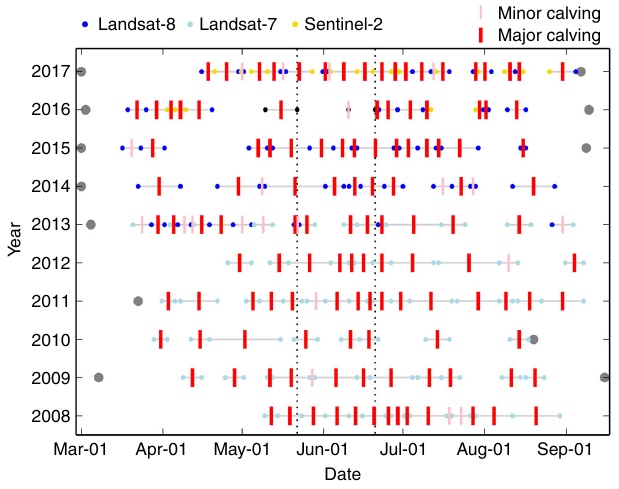
Fig. 4 Calving events inferred from TRI and satellite images. Due to limited temporal sampling of the data, we are not able to determine the exact time of each calving event. Instead, we mark each calving event in time de fi ned by the closest two usable images (colored dots), de fi ned as no dense cloud coverage at the glacier front in the satellite images. Black dots at 9 and 21 May 2016 represent the acquisition times of two Sentinel-1 images. Black dots at 10 and 20 June 2016 represent acquisition times of TRI images. Two vertical dotted lines mark the 30-day period between 21 May to 20 June. For each year, the time between the grey dot on the left ( fi rst acquisition of satellite image between the study period of the year) and the useable image represent the earliest period without calving. If the image represented by the fi rst blue or light blue dot shows no calving events compared to an image before 00:00 1 March in the corresponding year, we put the grey dot at 00:00 1 March. E.g., Landsat-8 images acquired at 14:54 26 February 2017 to until 14:54 15 April 2017 show no calving event during this period. If there is no grey dot on the left of the corresponding year (in 2008, 2010, 2012, due to cloud coverage on Landsat-7 optical images), then the fi rst light blue dot represents the fi rst usable image in the corresponding year. Similarly, grey dot on the right for each year indicates the last usable image that shows no calving event compare to the image shown by the last blue or light blue dot in the corresponding year. If there is no grey dot on the right of the corresponding year, it is either because the last blue or light blue dot marks the last usable image, or some calving events occurred after the last shown date in the corresponding